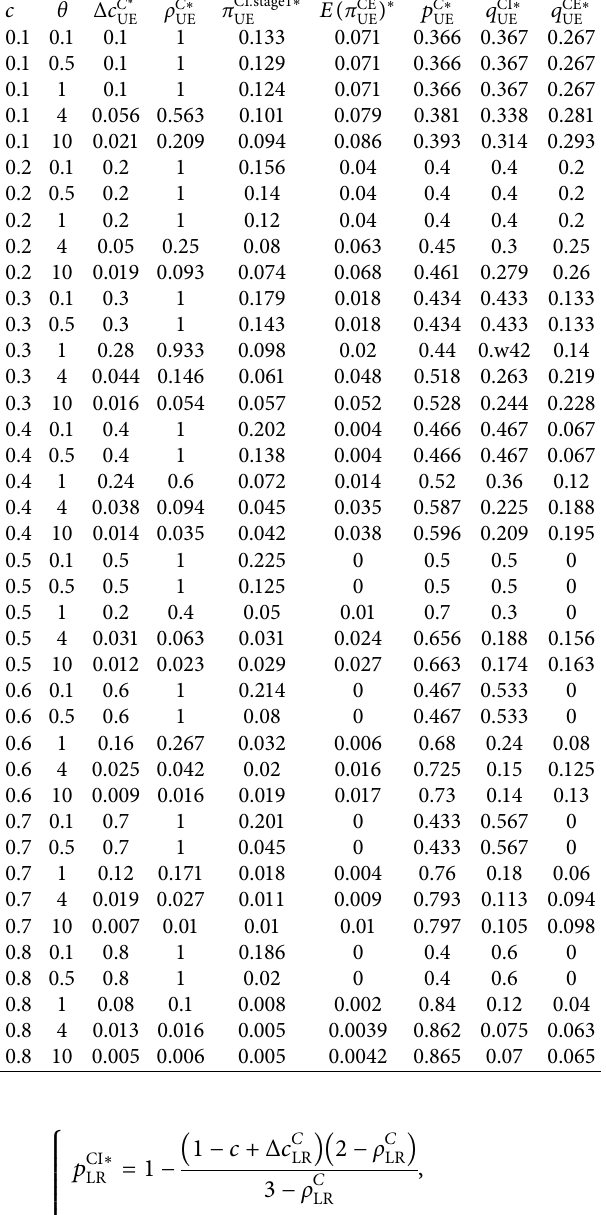
Table 2: A numerical example of market equilibrium under the unjust enrichment